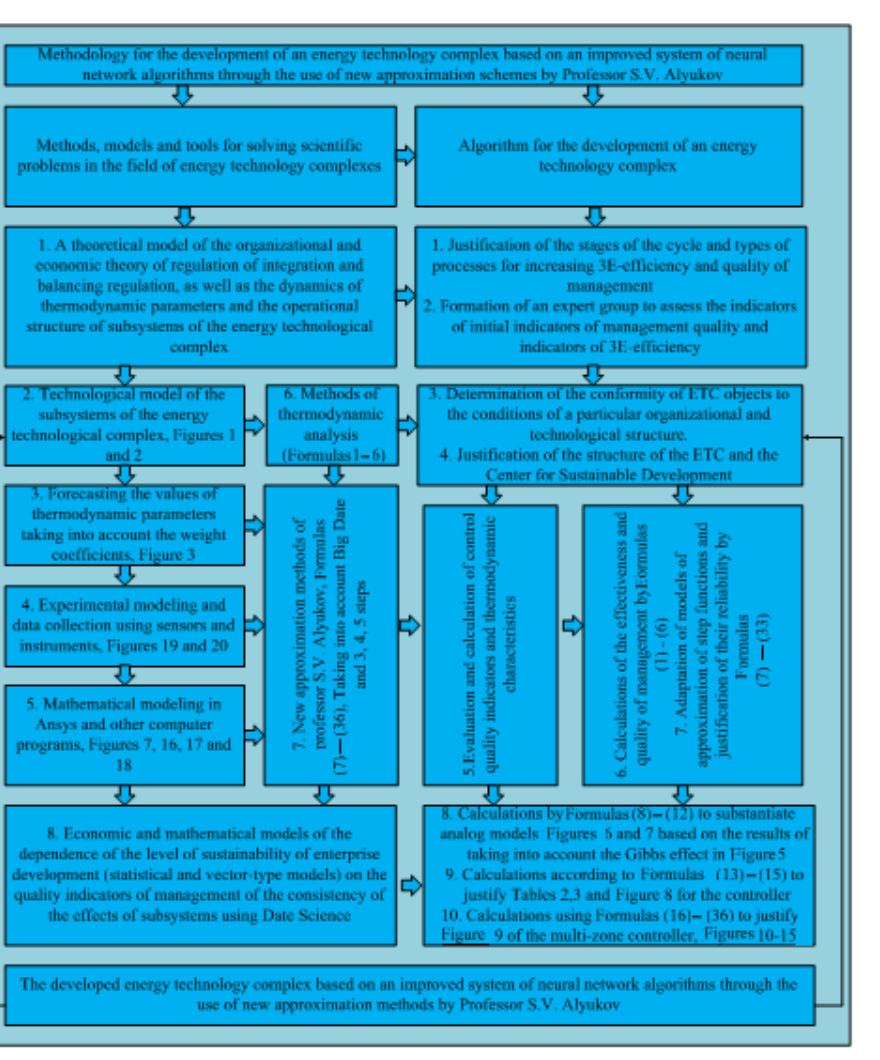
Figure 4. Algorithmic scheme of the methodology for in-depth analysis of the quality of regulation of parameters of an energy technology installation using data science tools via a combination of organizational, economic, technical, technological, and mathematical methods.